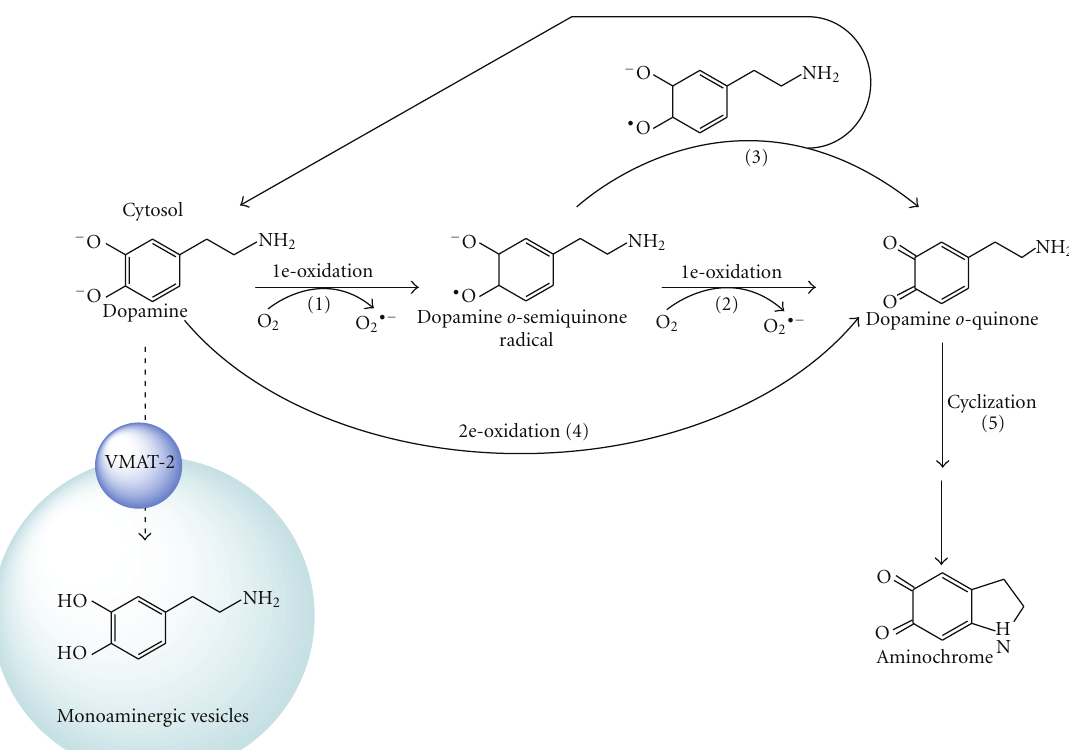
Figure 3: Dopamine oxidation to aminochrome at physiological pH. Dissociated dopamine can be oxidized to a dopamine o -semiquinone radical by the reduction of one molecule of oxygen to form a superoxide radical. The dopamine o -semiquinone radical can then disproportionate with another dopamine o -semiquinone radical, generating one molecule of dopamine and one molecule of dopamine o -quinone. Alternatively, the dopamine o-semiquinone radical can undergo one-electron oxidation to dopamine o -quinone by reducing one molecule of molecular oxygen to a superoxide radical. Dopamine o -quinone immediately cyclizes to form aminochrome, which is only stable in environments below pH